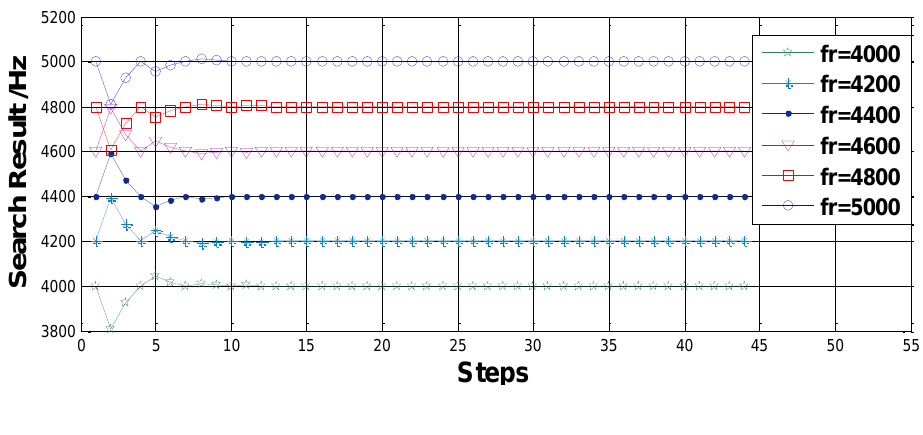
Figure 8. Measurement results for different resonant frequencies using the search